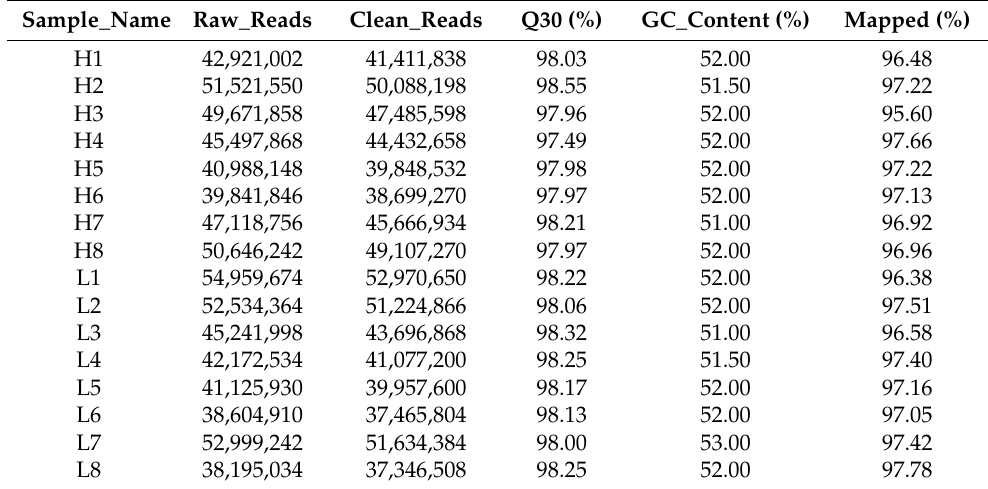
Table 2. RNA sequencing data analysis.